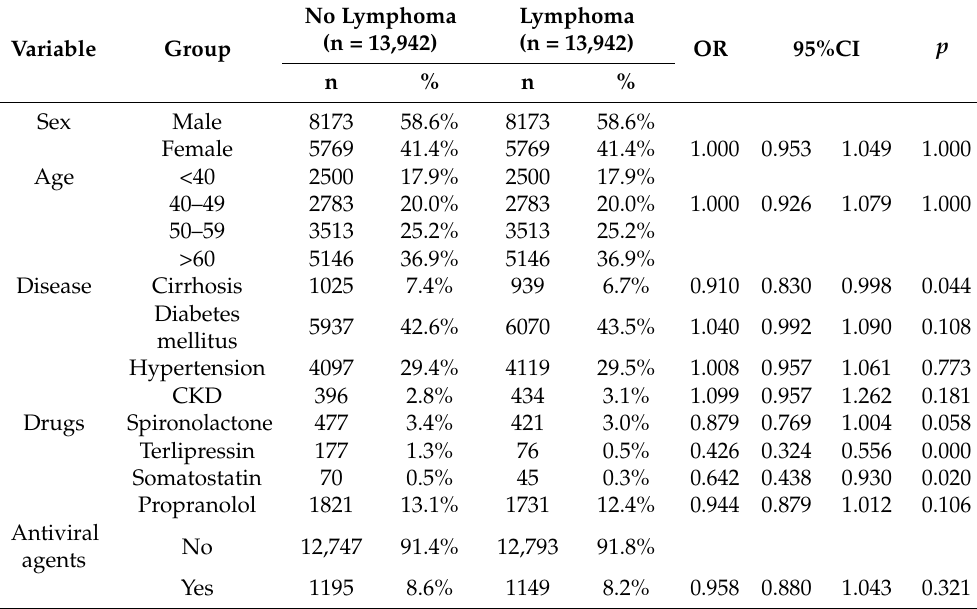
Table 1. Characteristics of HBV patients with and without malignant lymphoma